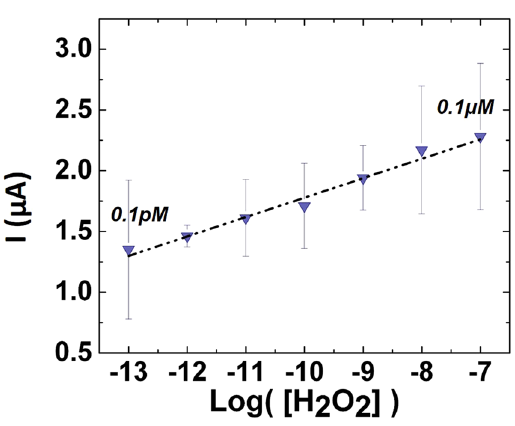
Figure 5. Sensor detection range for H 2 O 2 . The detection range is across seven orders of magnitude from 0.1 pM to 0.1 μ M. The concentration is represented as the log value of the molar concentration. Sensitivity is determined from semi-log plot as: 0.156 μ A/log(M) * cm 2